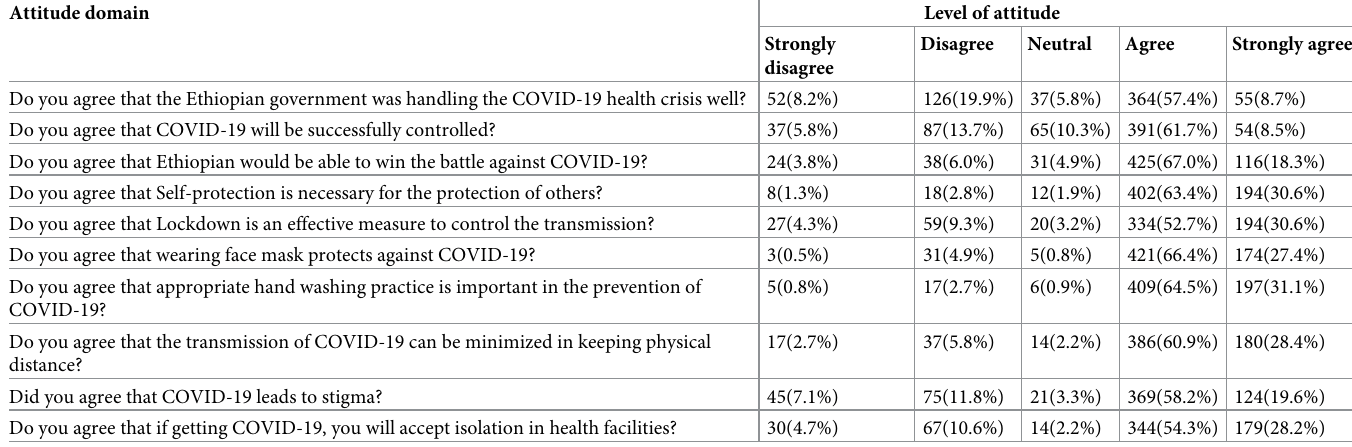
Table 3. The level of attitude towards the prevention of COVID-19 among residents in Guraghe Zone, 2020 (n = 634). Attitude domain